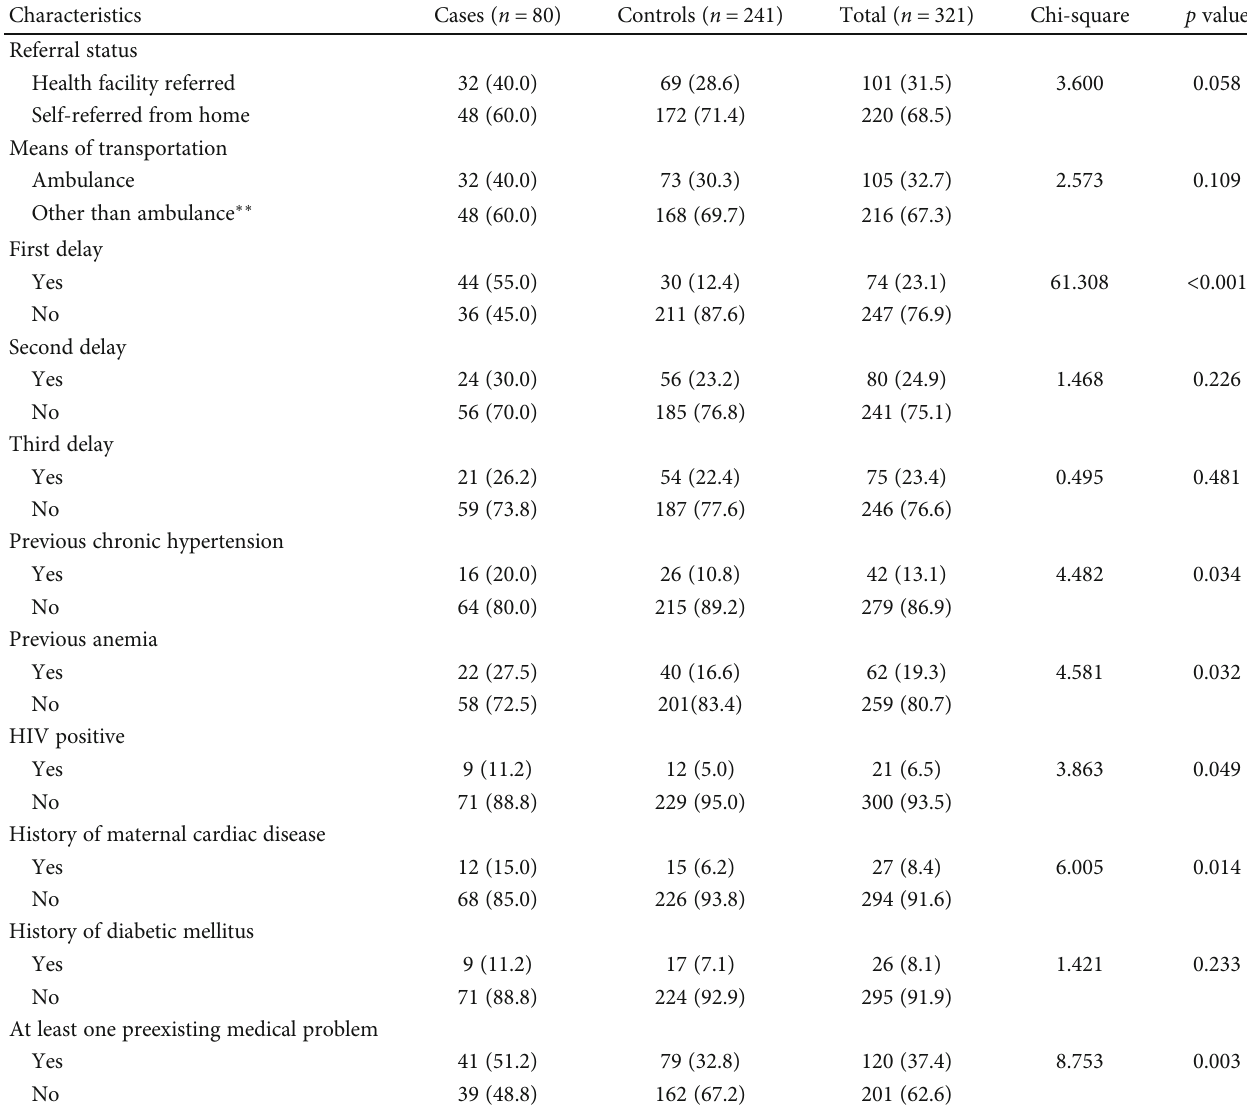
Table 3: Preexisting chronic medical disorders and maternal obstetric health care delays among women admitted in Western Arsi zone public hospitals, Ethiopia,